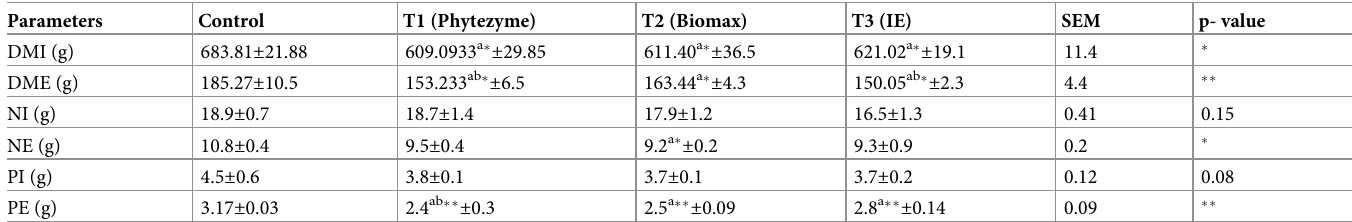
Table 3. Nitrogen and phosphorous content of broiler